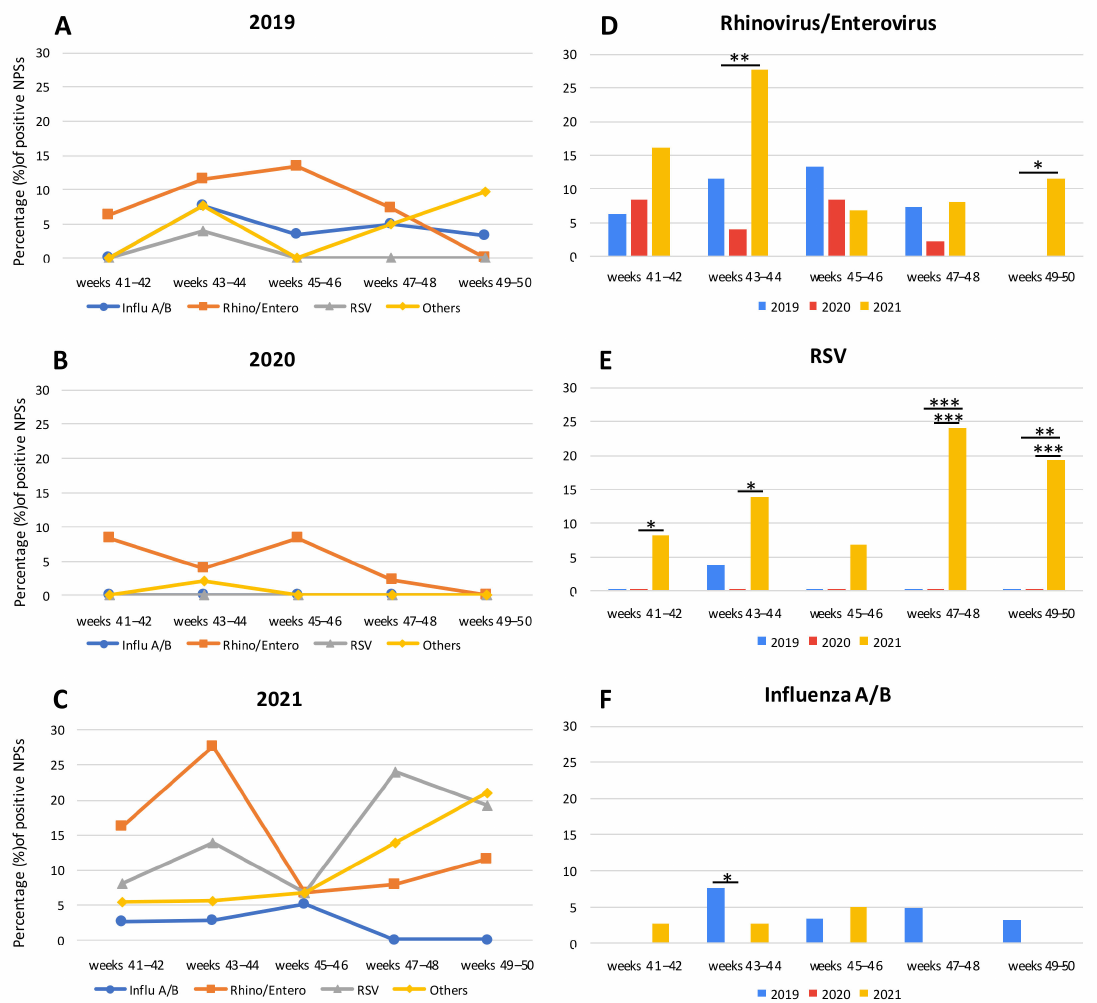
Figure 1. Biweekly percentage of NPSs positive for CRPs during the fall season of 2019, 2020, and 2021. ( A – C ): Seasonal circulation of CRP-positive samples during fall 2019, 2020, and 2021, respectively. ( D – F ): Biweekly of CRP-positive samples in comparison with the same interval periods during 2019, 2020, and 2021. Asterisks indicate statistically significant differences determined by Student’s t test (*** = p < 0.001; ** = p < 0.01; * = p < 0.05; no asterisk = not